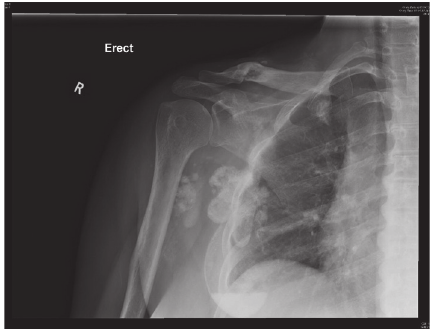
Figure 6: Radiograph of the right shoulder 2 years after teriparatide